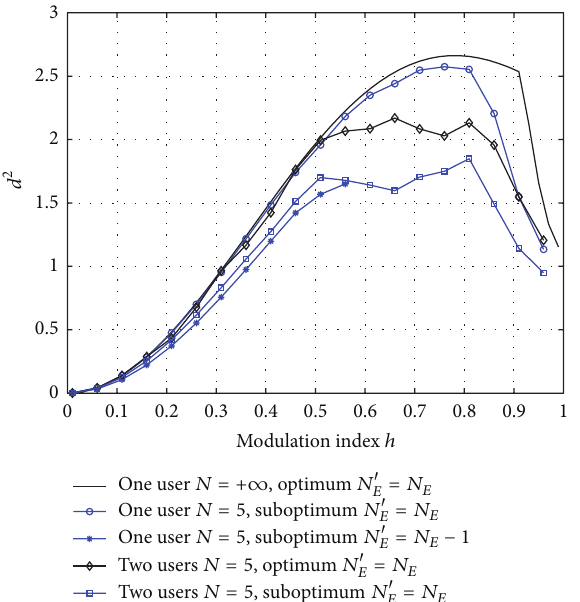
Figure 3: The minimum achievable distance 𝑑 2 versus the modula- tion index ℎ for suboptimum ( 𝐿 𝑅 < 𝐿 ) receivers. Δ𝑓 = 0 and Δ𝜙 is optimized.